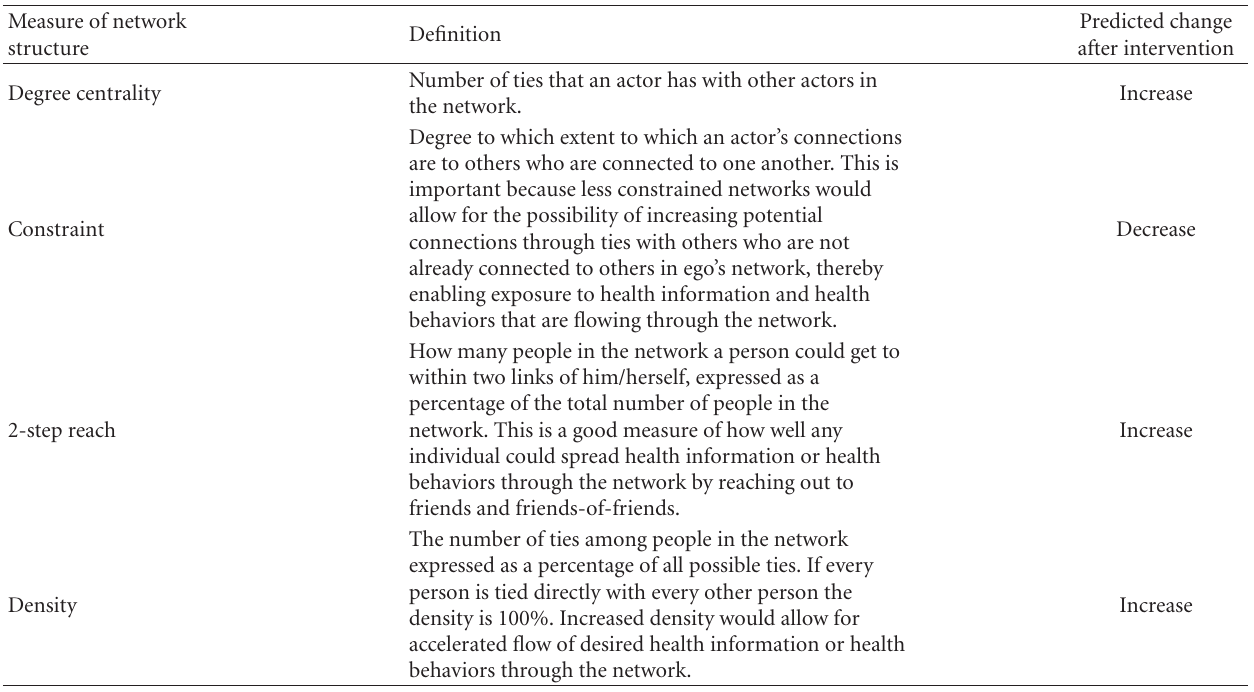
Table 1: Measures of network structure and predicted